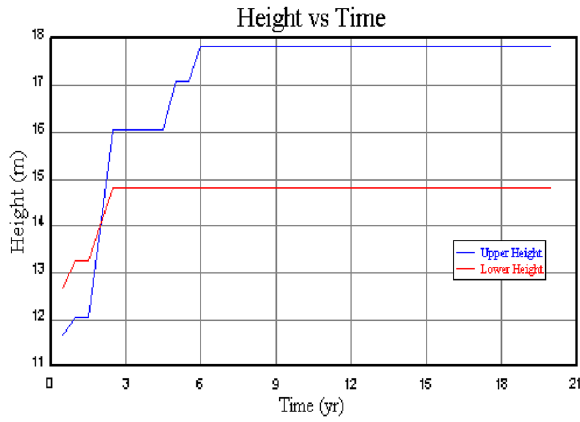
Fig. 13 Field Studied case thermal and fracture